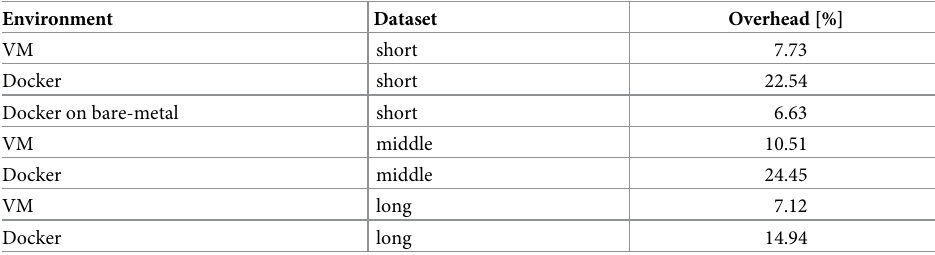
Table 6. Average overheads over all used CPU core numbers of VM and Docker runs and one run of Docker directly on bare-metal. The overhead numbers are related to the bare-metal benchmarks, expressed in percentages, including the used dataset.